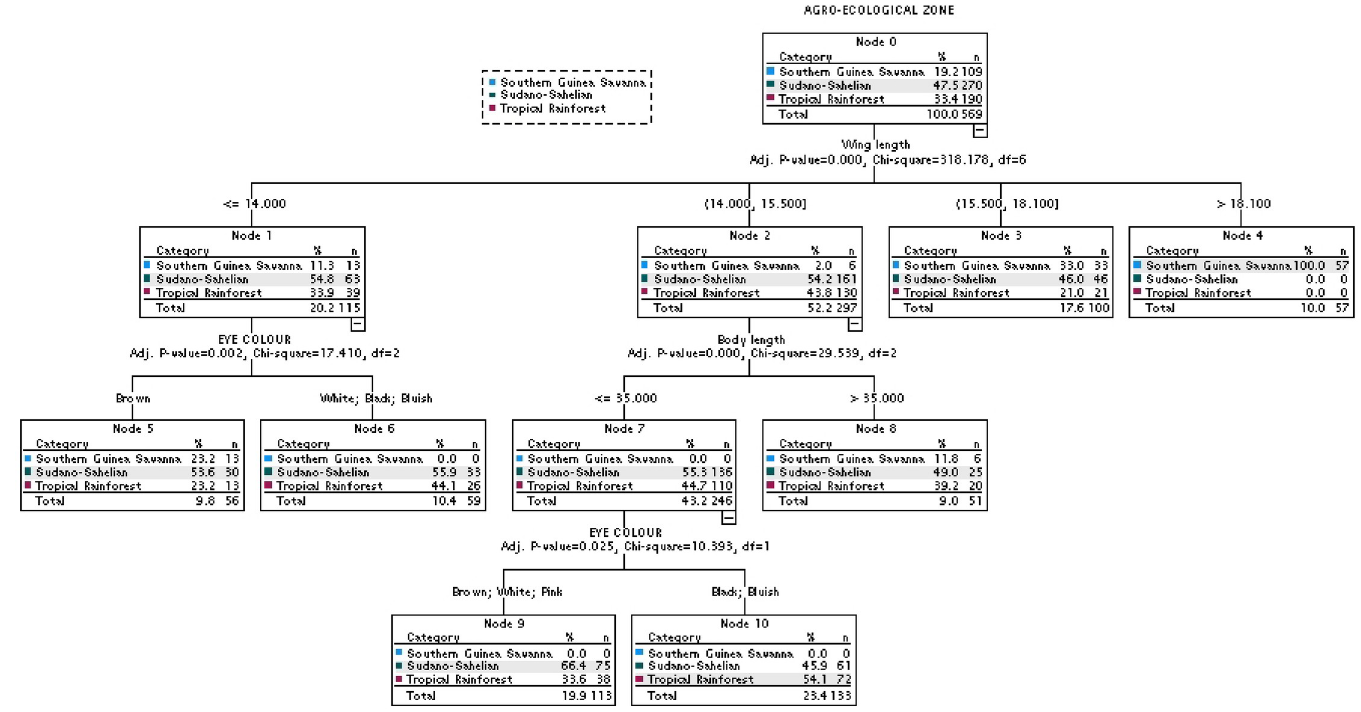
Fig 6. The association between the agro-ecologies and the phenotypic traits using Exhaustive CHAID.